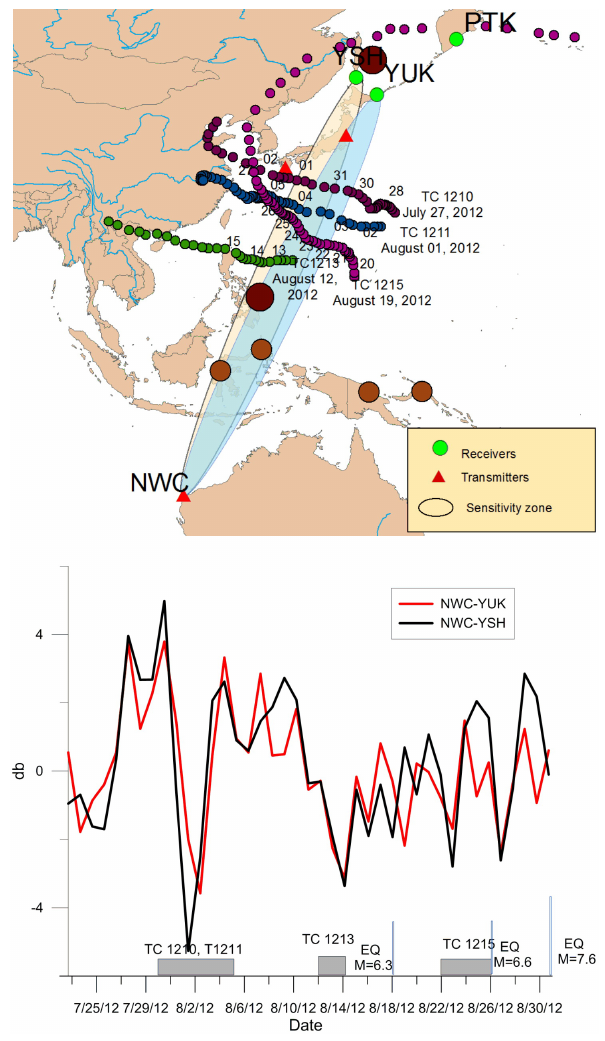
Figure 7. The anomalies in the NWC signal recorded at the YSH and YUK stations during the passage of several TCs in August 2012 (the bottom panel). Horizontal grey bars on the abscissa show the periods when the TCs crossed the sensitivity zones of the paths un- der consideration, and blue vertical bars refer to the times of the earthquake occurrences. The epicentres of earthquake with M >6, which took place in the Pacific region during the period of analysis, are shown in the top panel by large solid brown